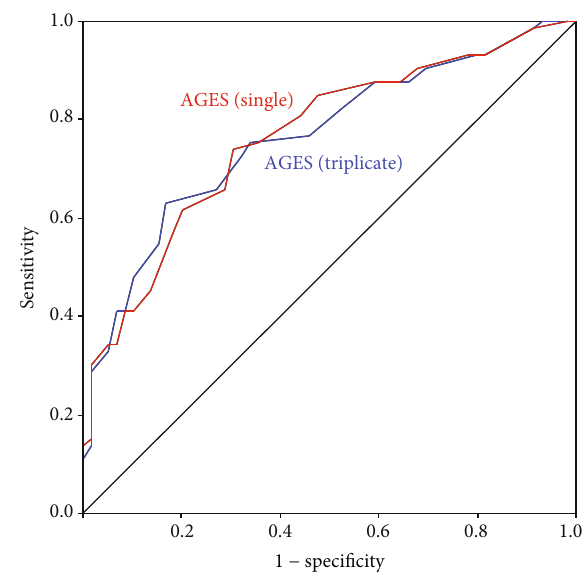
Figure 2: ROC analysis for the evaluation of the diagnostic signi fi cance of AGEs (single measurement) and AGEs (triplicate measurement) for small fi bre